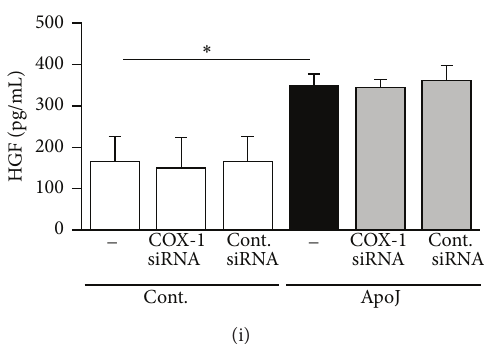
Figure 3: Inhibition of COX-2 downregulates HGF expression. RAW 264.7 cells were pretreated with NS-398 or indomethacin (Indo) for 1h and then stimulated with apoptotic Jurkat cells (ApoJ) for 2 h to detect HGF mRNA expression (a, b) or for 24 h to detect secreted HGF (c). RAW cells were transfected with COX-2 or control vehicle (siRNA-GFP) for 6 h and then incubated with ApoJ for 2 (d, f) or 24 h (e, g). (h, i) RAW cells were transfected with COX-1 siRNA or control vehicle (siRNA-GFP) for 48h and then incubated with ApoJ for 24 h. (a, b, c) HGF mRNA levels were analyzed using semiquantitative RT-PCR and normalized to 𝛽 -actin mRNA levels. (d, e, h) Immunoblots of total cell lysates were performed with anti-COX-2 or COX-1 antibodies. (c, g, i) HGF levels in conditioned media were measured by ELISA. Values represent mean ± SEM of three or more separate experiments; ∗ 𝑃 < 0.05